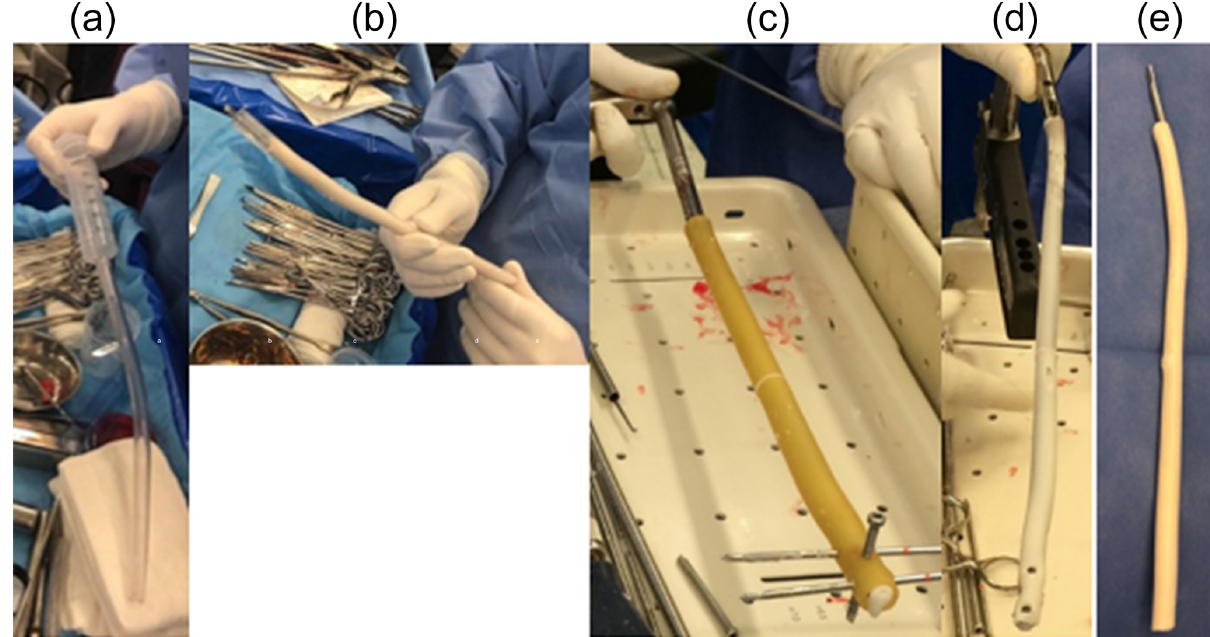
Figure 1. Images showing how ATB nails were manufactured in the operating room. (a) Preparation of the plastic chest tubes and the syringe for cement insertion. (b) Ender nail insertion into the cemented tube. (c) Insertion of the nail into the cemented tube and pines into the locking holes. (d, e) Images of the nail